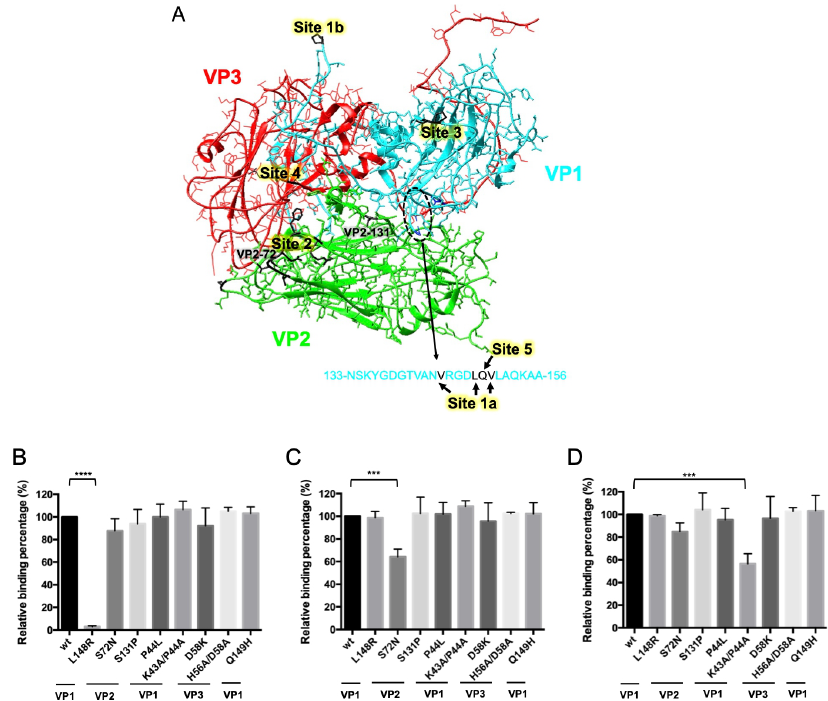
Figure 1. Schematic of neutralizing sites for serotype O and the relative binding percentages between MAbs and mutated VLPs. ( A ) The critical residues of the neutralizing sites were illustrated on a protomer of O1M-S093Y (PDB 5ddj) using the UCSF Chimera software. ( B – D ) Sandwich ELISA was performed with the VLPs and mutated VLPs to determine the relative binding strength (compared with the wild type) of the MAbs, including Q10E ( B ), P11A ( C ), and S11B ( D ). The relative binding percentages of the mutated VLPs were compared with those of the wild-type (100%) using ANOVA with Dunnett’s test. Each test was performed in triplicate. L148R—VP1-L148 mutated VLP; S72N and S131P—mutations of VLP2 in indicated amino acids; P44L and K43A/P44A—site 3 mutated VLPs; D58K and H56A/D58A—site 4 mutated VLPs; Q149H—site 5 mutated VLP. **** p < 0.0001, *** p <